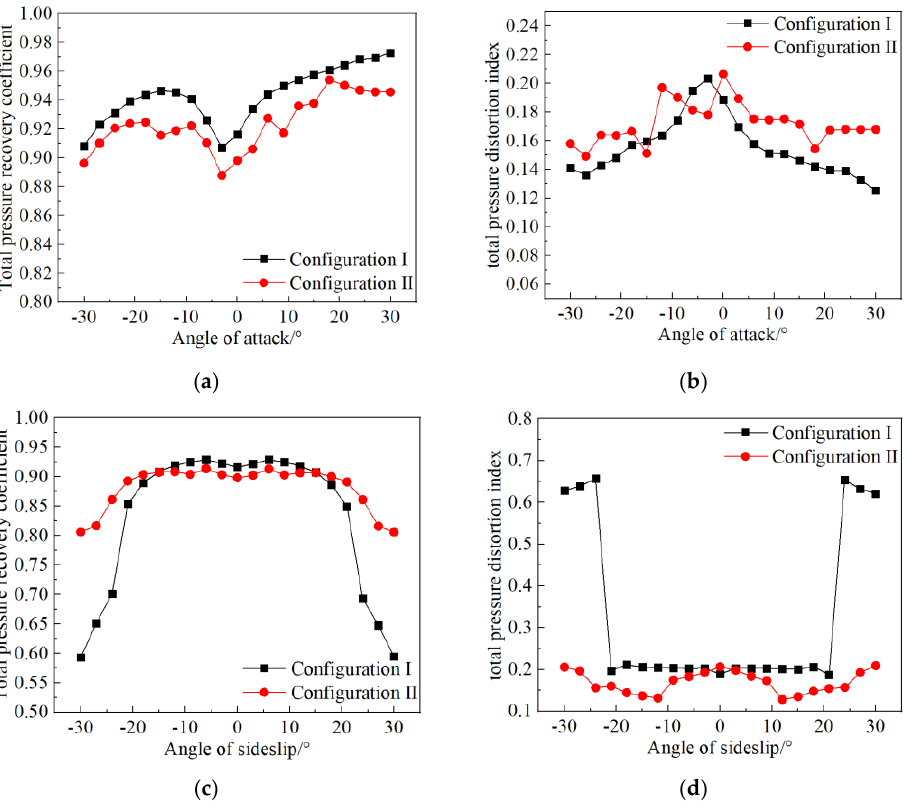
Figure 11. Steady State Calculation Results.(a) Total pressure recovery coefficient versus angle of attack ,(b) Total pressure distortion index versus angle of attack,(c) Total pressure recovery coefficient versus angle of sideslip,(d) Total pressure distortion index versus angle of sideslip